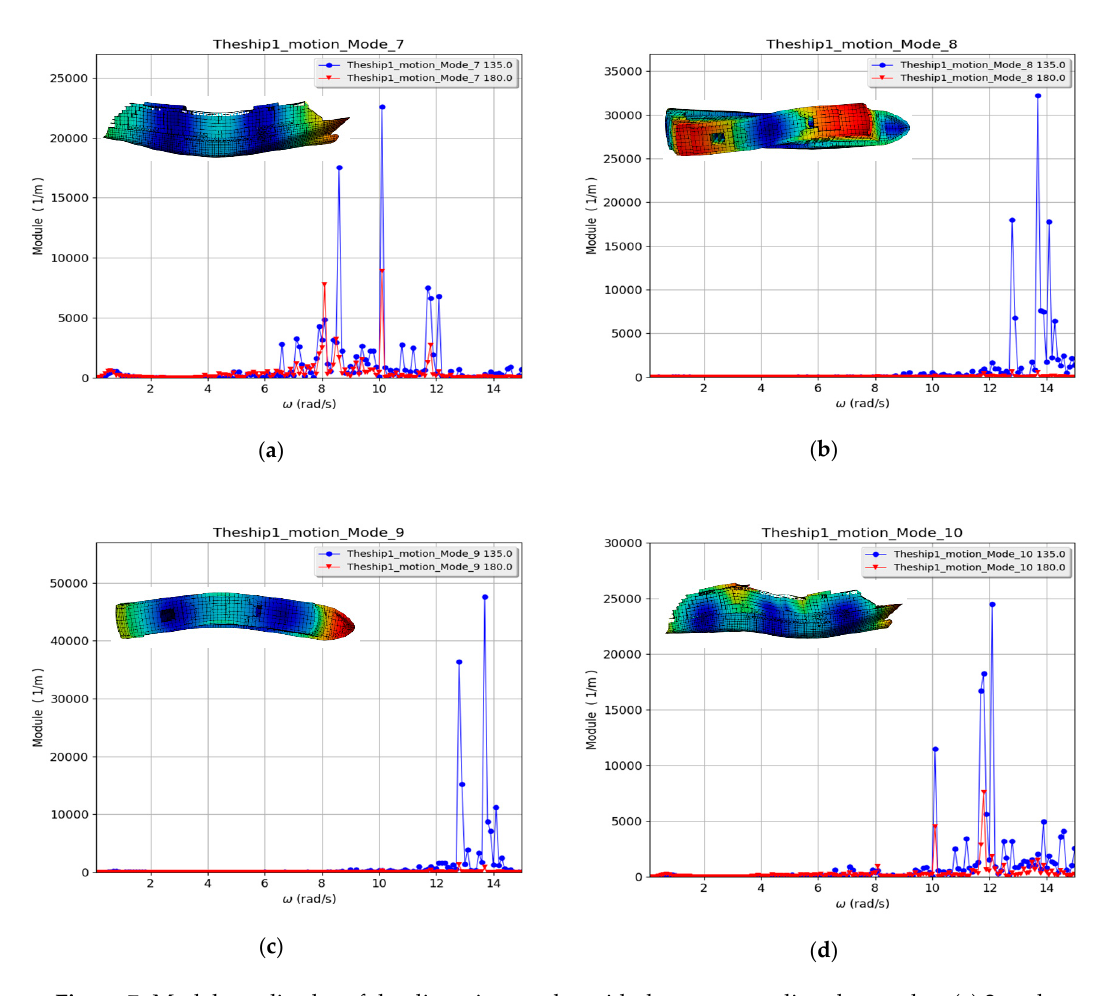
Figure 7. Modal amplitudes of the distortion modes with the corresponding dry modes. ( a ) 2-node VBM mode at 12.56 rad / s ( b ) 1-node torsion mode at 14.56 rad / s ( c ) 2-node HBM mode at 14.92 rad / s VBM mode at 12.56 rad/s ( b ) 1-node torsion mode at 14.56 rad/s ( c ) 2-node HBM mode at 14.92 rad/s ( d ) 3-node VBM mode at 17.27 rad / ( d ) 3-node VBM mode at 17.27 rad/s.